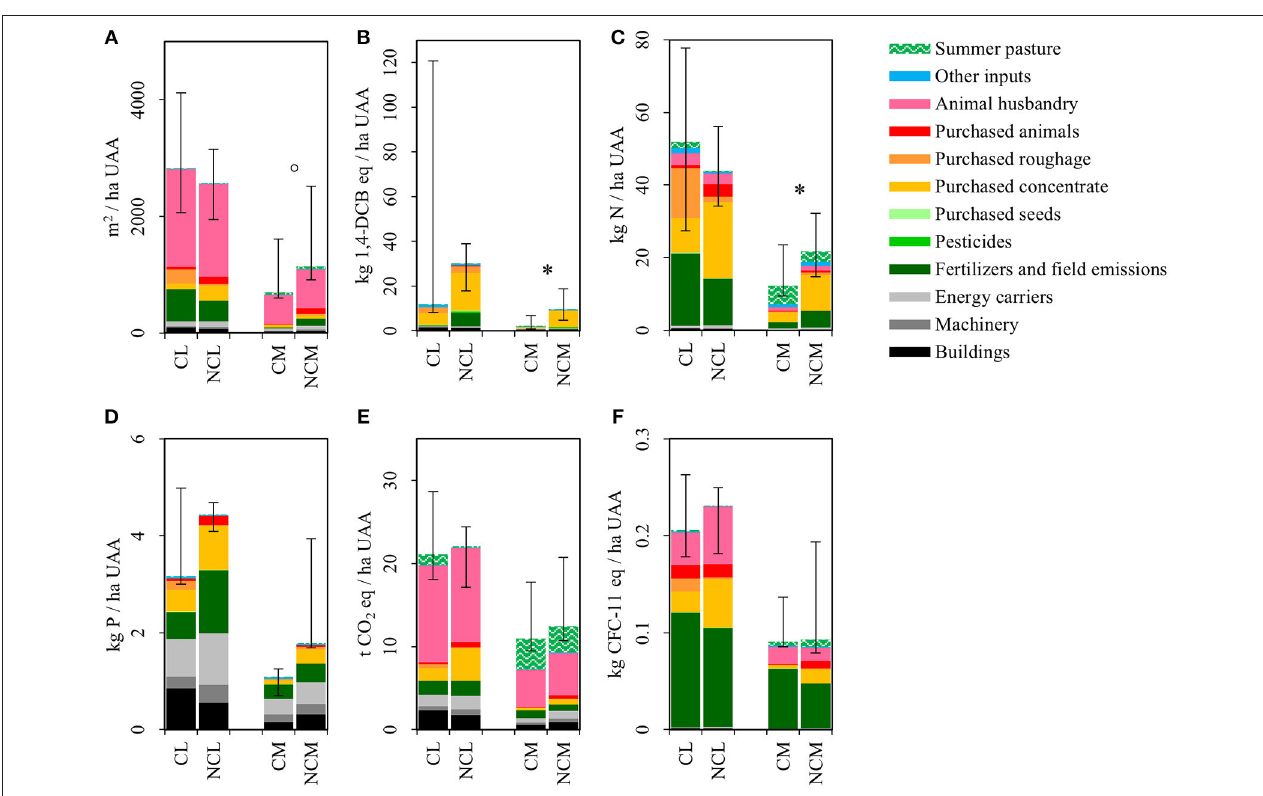
FIGURE 3 | Environmental impact per hectare usable agricultural area (ha UAA) for impact categories related to emissions into the ecosphere: (A) acidification, (B) terrestrial ecotoxicity, (C) eutrophication due to N, (D) eutrophication due to P, (E) global warming potential, (F) ozone depletion potential. Bars indicate the median performance of each farm group (CL, collaborating lowland farms; NCL, non-collaborating lowland farms; CM, collaborating mountain farms; NCM, non-collaborating mountain farms) and sources of impacts. Whiskers indicate the minimum and maximum impact within each group, *indicate significant differences between farm groups within a given region ( p < 0.05), ◦ indicate tendencies ( p ≤